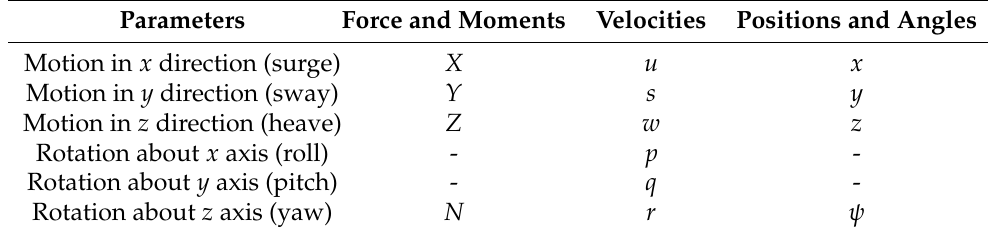
Table 1. The parameters in an autonomous underwater vehicle model. Parameters Force and Moments Velocities Positions and Angles Motion in x direction (surge) X u x Motion in y direction (sway) Y s y Motion in z direction (heave) Z w z Rotation about x axis (roll) - p - Rotation about y axis (pitch) - q - Rotation about z axis (yaw) N r